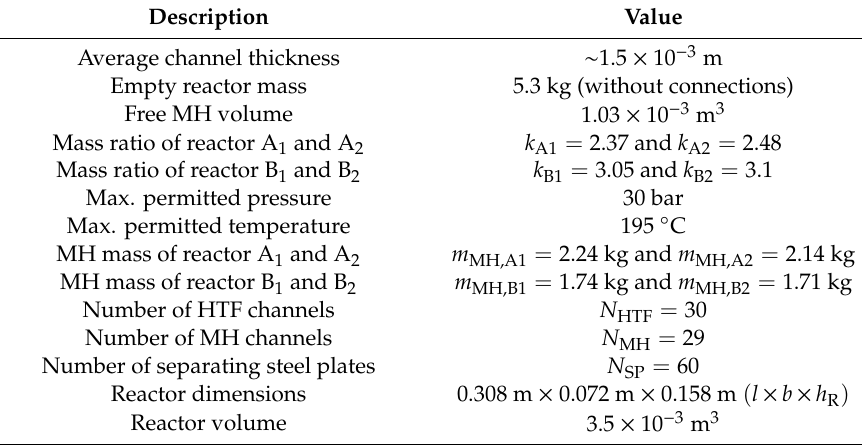
Figure 3. Design of the realized plate reactor. Right: cross-sectional view. Table 1. Characteristics of the plate